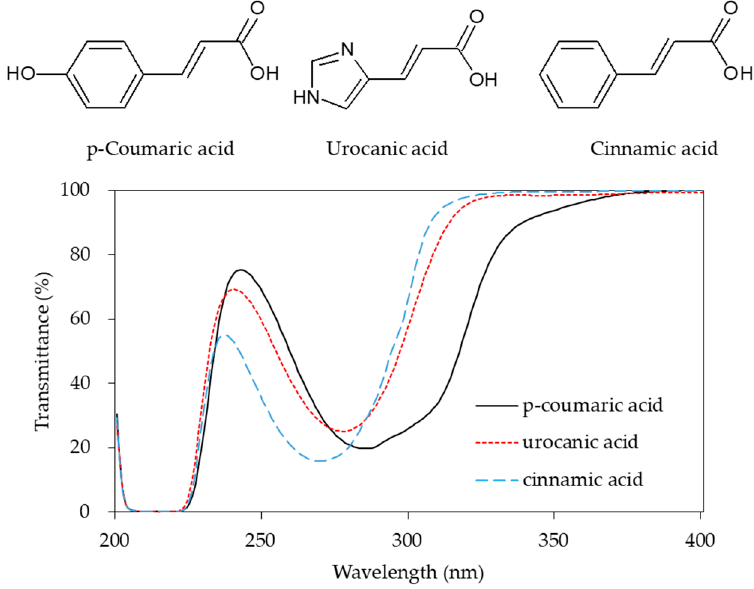
Figure 2. Chemical structures and ultraviolet (UV) transmittance spectra of p-coumaric acid, urocanic acid, and cinnamic acid. The compounds were dissolved in phosphate buffered saline at 30 μ